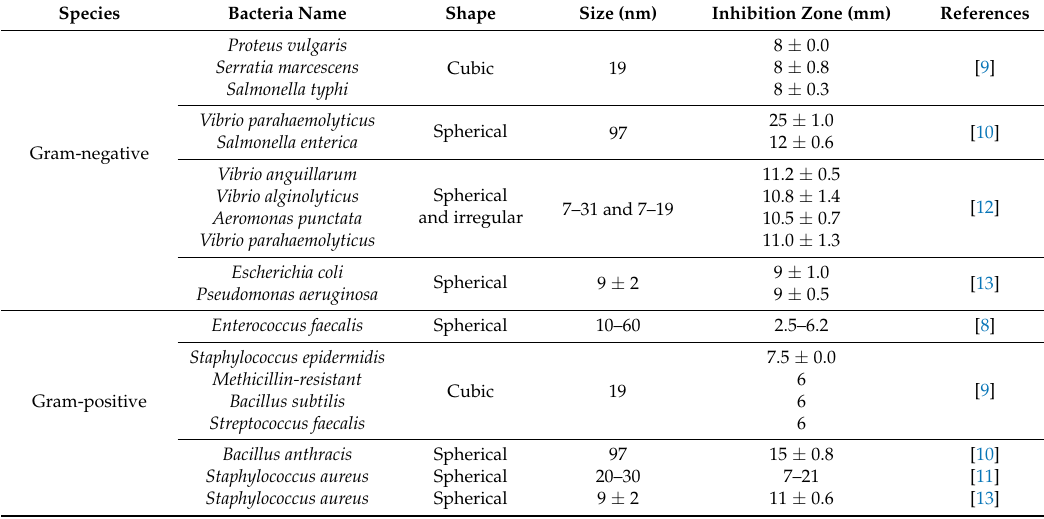
Table 5. Antibacterial capability of AgNPs against several